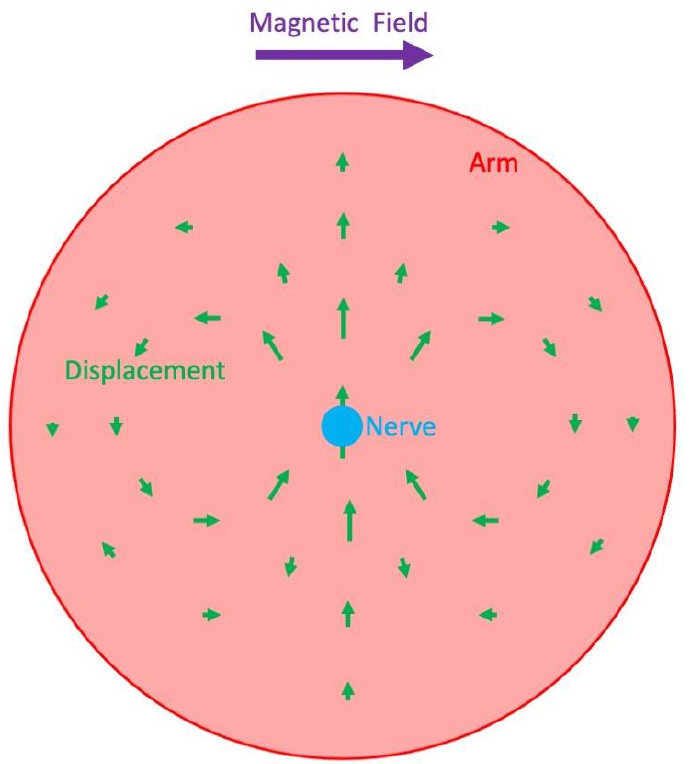
Figure 6. The displacement caused by the Lorentz force acting on a nerve in a magnetic field. The nerve (blue) is shown in cross section and is centered in an arm (red). It carries an action current that is directed out of the paper. The magnetic field (purple) is to the right. The displacement arrows (green) are exaggerated in this illustration to make them easier to see. Adapted from Figure 2 in [17].